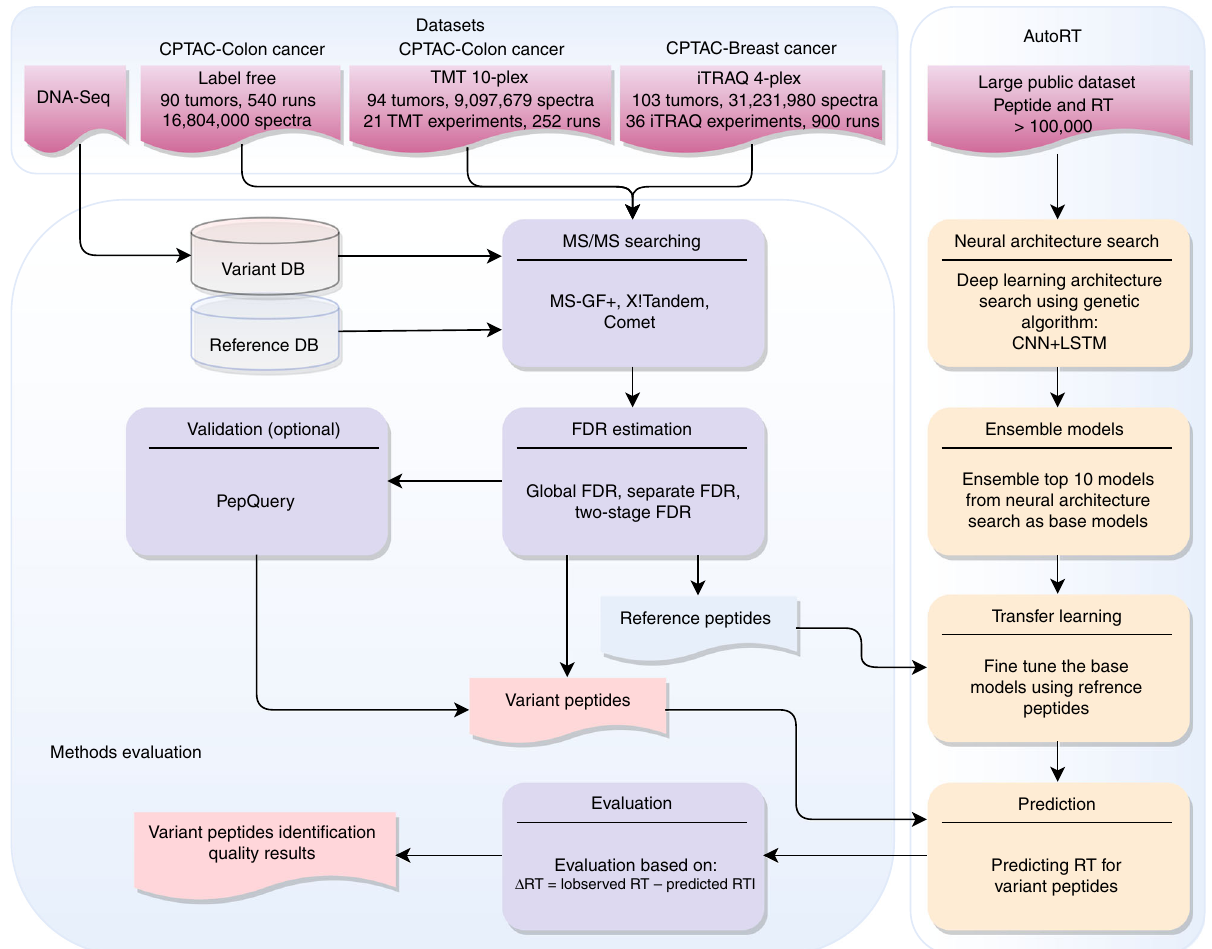
Fig. 1 An overview of the study design. The left panel shows the overall study design including data sets, customized database construction, search engines used, different quality control strategies, and the variant peptide identi fi cation evaluation method. The right panel shows the development and application of the peptide retention time (RT) prediction